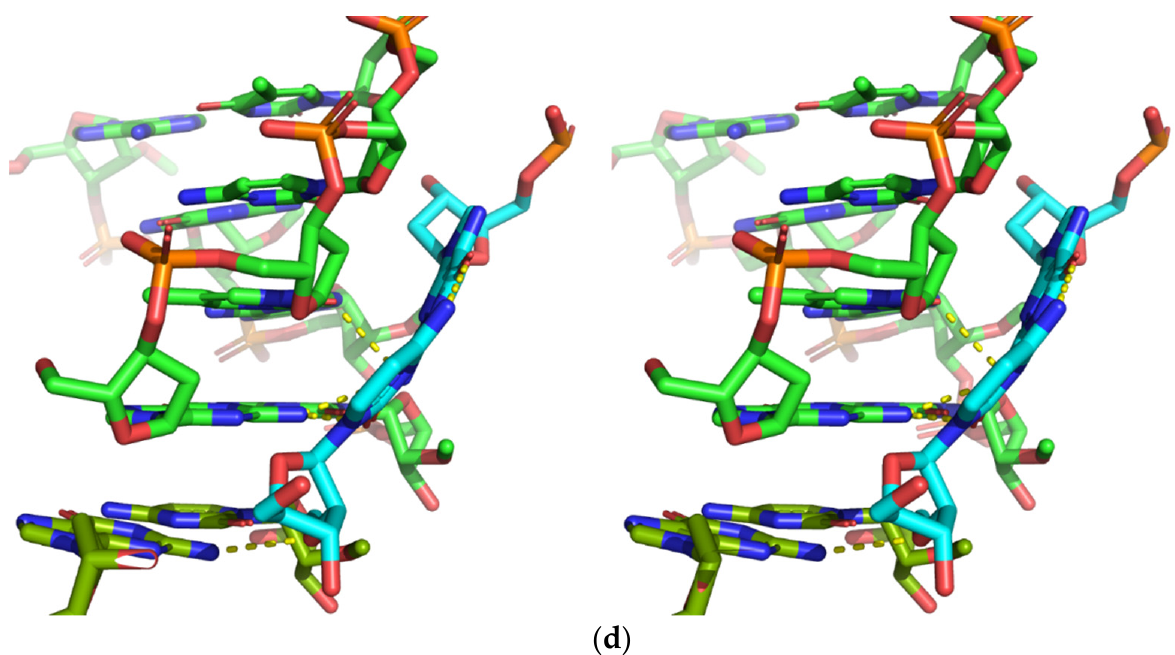
Figure 6. 3wj-YdG interaction: ( a ) original motif sequence; ( b ) secondary structure pattern; ( c ) 3D representation of 3wj-YdG interaction derived from pdb:7osx; ( d ) tertiary structure in stereoscopic 3D view (parallel). Hydrogen bonds are indicated by yellow dashed lines.